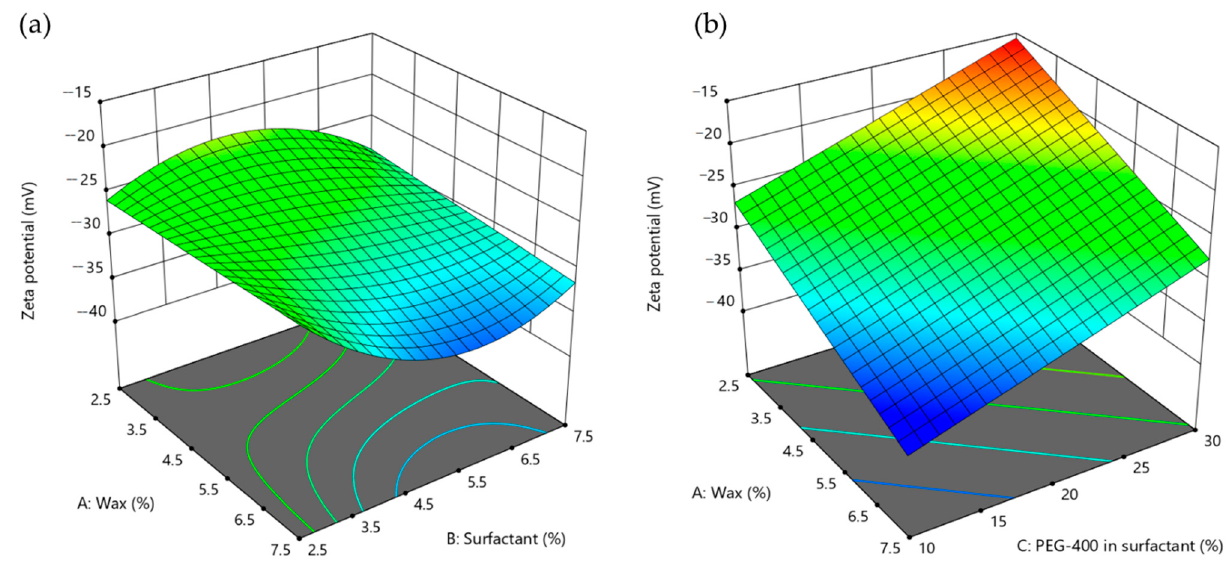
Figure 3. The response surface plot presents the effects of wax, surfactant, and PEG percentage in the surfactant on the zeta potential of the SBO-NLCs. ( a ) Interaction of wax and surfactant. ( b ) Interaction of wax and PEG400 percentage in the surfactant.